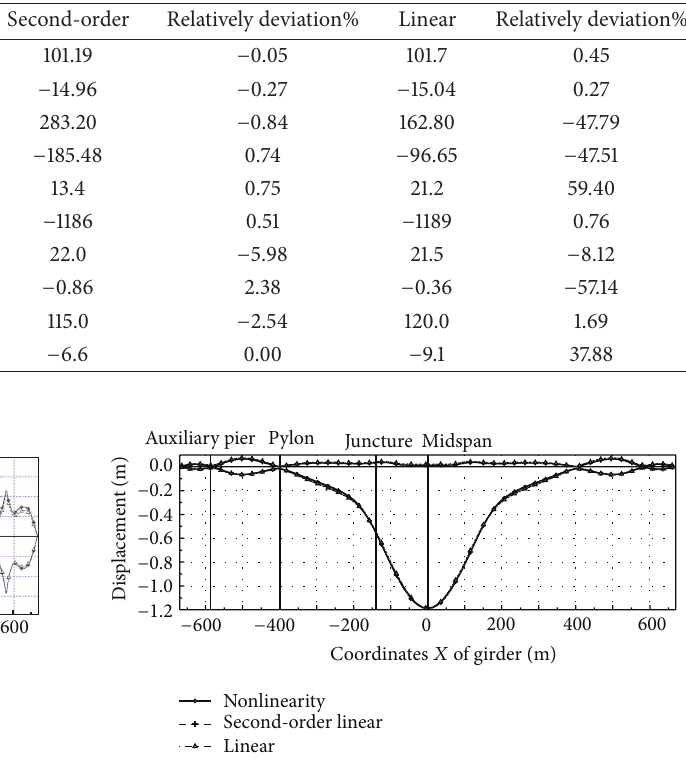
Figure 2: Envelope of main girder moment. Figure 3: Envelope of main girder